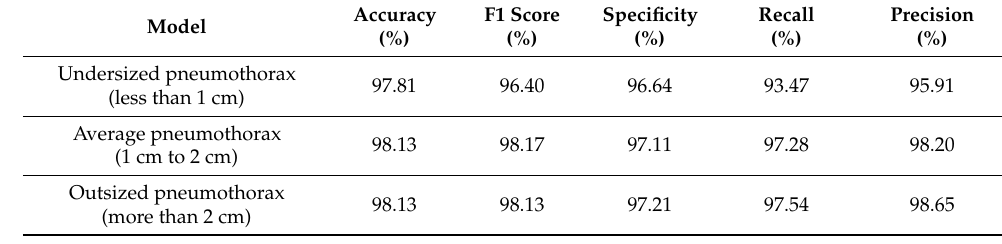
Table 9. Proposed method’s results for different sized pneumothoraces.